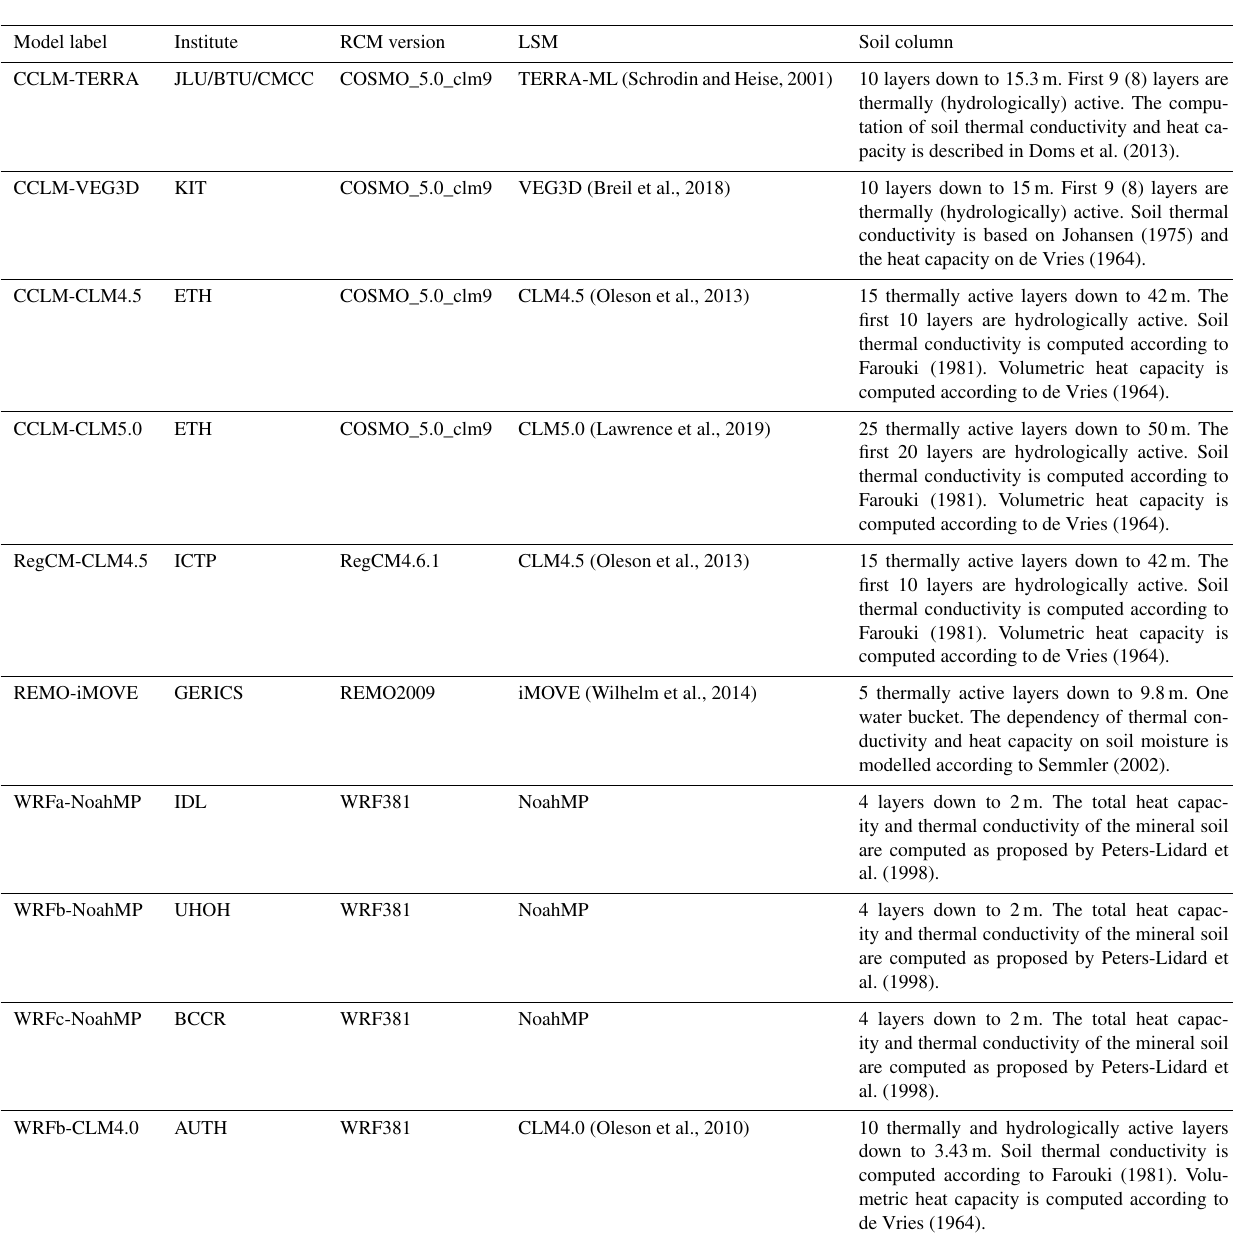
Table 1. Characteristics of the RCMs participating in the study. JLU – Justus-Liebig-Universität Gießen; BTU: Brandenburgische